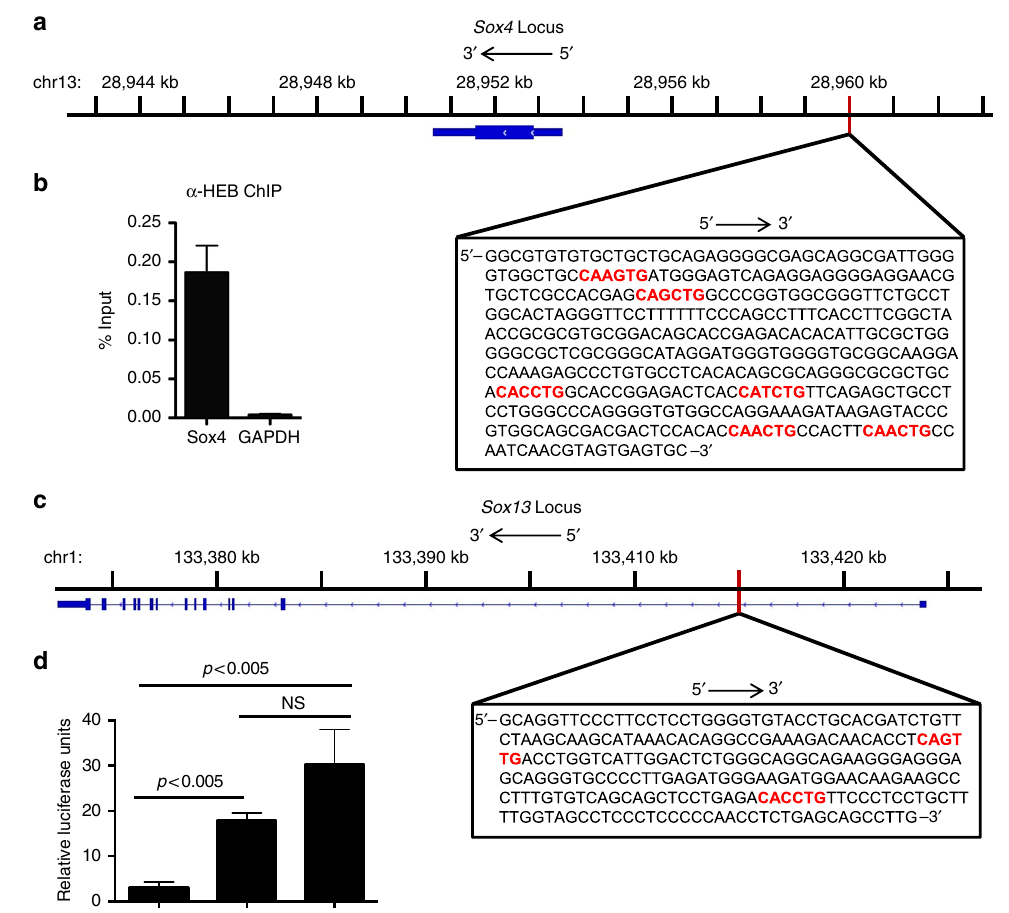
Fig. 6 HEB factors interact with Sox4 and Sox13 regulatory regions. a Structure of the Sox4 locus (oriented 3 ′ – 5 ′ ) and nucleotide sequence (boxed; oriented 5 ′ – 3 ′ ) of the region targeted for ampli fi cation to detect occupancy by HEB in Rag-2 de fi cient DN3 cells derived from fetal liver OP9-DL4 co-cultures. Blue boxes and lines indicate intron-exon structure of the Sox4 locus. Potential HEB E-box binding sites are depicted in red. b quantitative real time-PCR results for detection of HEB or GAPDH protein occupancy on the region depicted in a after chromatin immunoprecipitation of lysates using anti-HEB antibodies. ChIP qRT-PCR results are shown as percent of input. Primers designed to amplify GAPDH were used as a negative control. c Structure of the Sox13 locus (oriented 3 ′ – 5 ′ ) and nucleotide sequence (boxed; oriented 5 ′ – 3 ′ ) of the region targeted for ampli fi cation by PCR to generate a luciferase reporter construct. Blue boxes and lines indicate intron-exon structure of the Sox13 locus. Potential HEB E-box binding sites are depicted in red. d Luciferase assay results from 293T cells transfected with the fi re fl y luciferase reporter construct containing the Sox13 region shown in c , the Renilla luciferase construct, and pCMV- based expression vectors (empty, HEBAlt, HEBCan). Results are representative of two independent experiments with three technical replicates each. Values are normalized to Renilla. Center values indicate mean, error bars denote s.e.m. p -values were determined by two tailed Student's t-